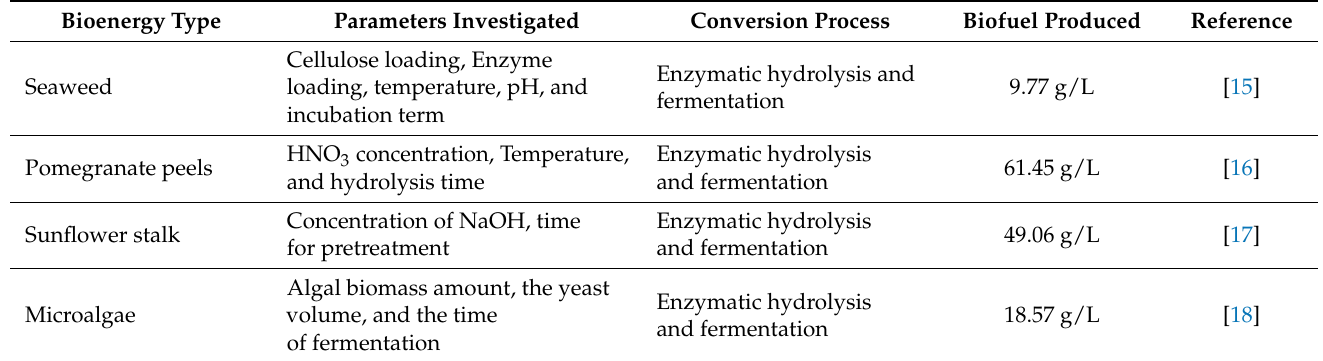
Table 1. Bioethanol production from various feedstocks and conversion